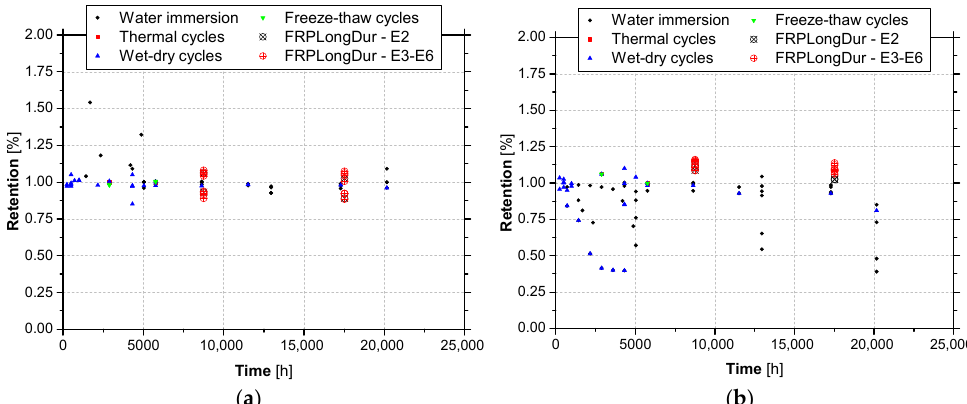
Figure 16. Retention values of ( a ) elastic modulus and ( b ) tensile strength of CFRP laminates under accelerated ageing tests